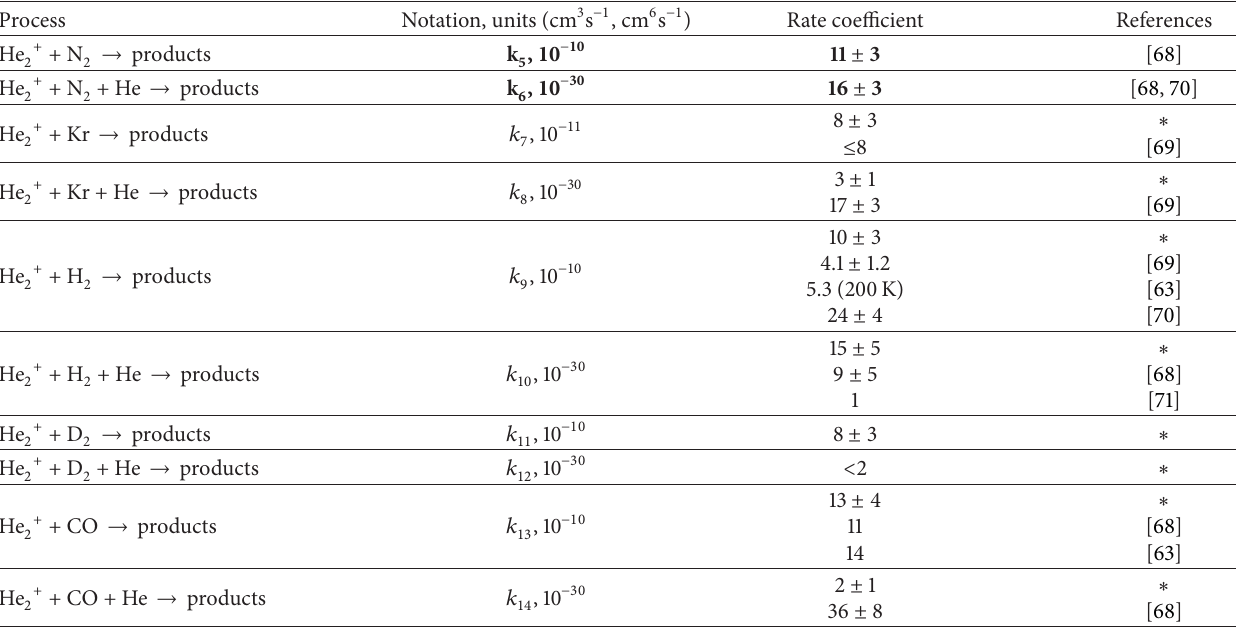
Table 3: Rate constants for processes involving He 2+ .